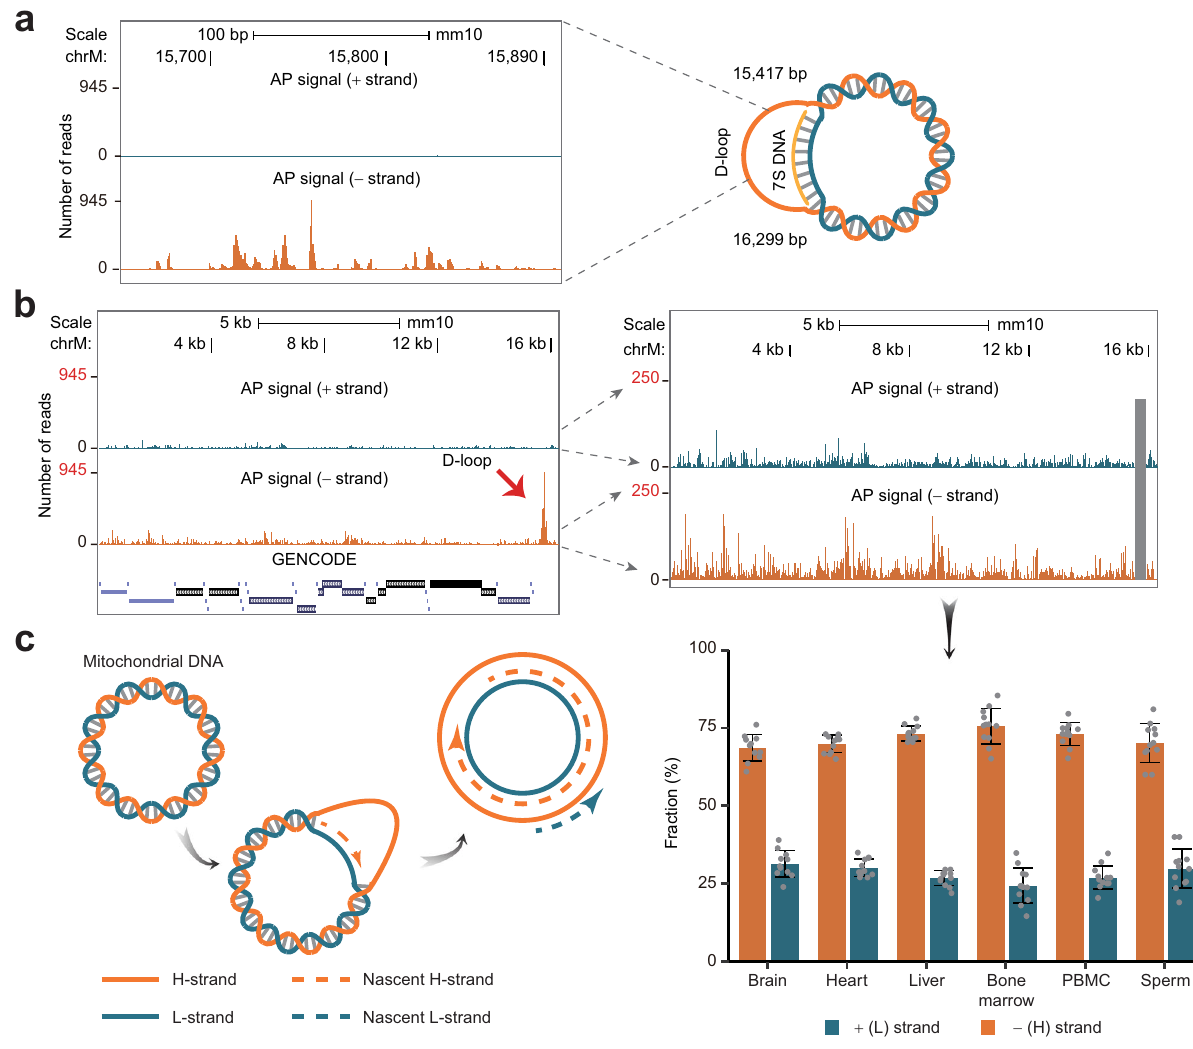
“ − ” strand in each tissue outside of the D-loop region. Data are presented as mean values+/ − SD based on 12 (3 biological replicates of 4 age groups) samples per tissue type with the exception of brain represented by 11 samples. c Diagram of replication for the H (heavy) and L (light) strands of the mitochondrial genome (corresponding to the “ − ” and “ + ” strands, respectively) based on the commonly accepted strand displacement model 42 . The distribution of AP sites ( Y -axes) is represented by the total number of reads corresponding to AP sites found at each nucleotide position across all 71 samples ( a , b ). Source data are provided as a Source data fi